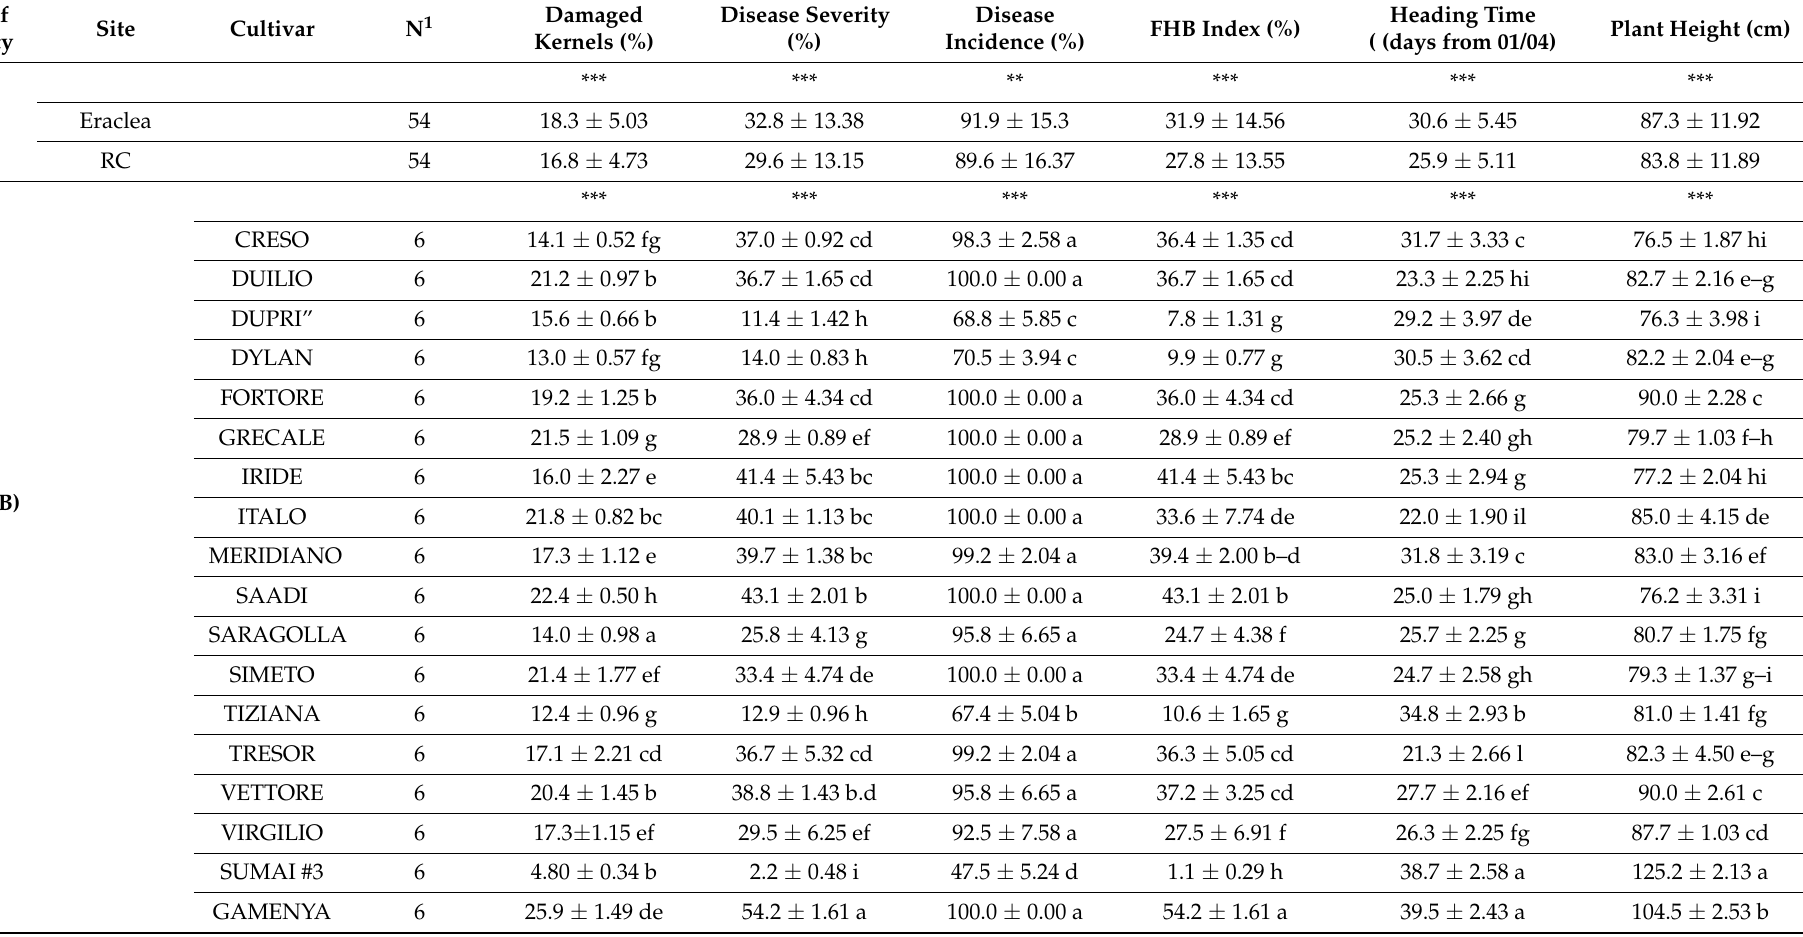
Table 3. Factorial ANOVA of the disease susceptibility indices and some morpho-physiological traits of 16 Italian durum wheat cultivars and 2 reference cultivars of bread wheat evaluated for their susceptibility to Fusarium head blight (FHB) 1 . The test was performed in two different sites in northern and southern Italy (Eraclea, Veneto region and Reggio Calabria, Calabria region,